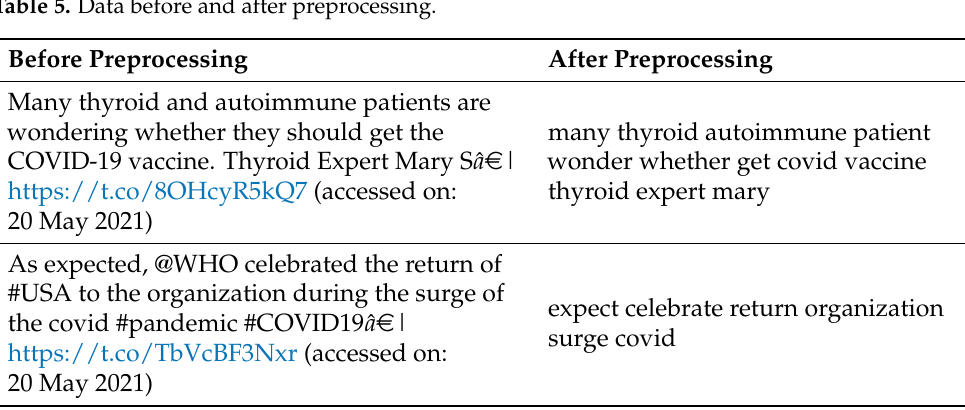
Table 5. Data before and after